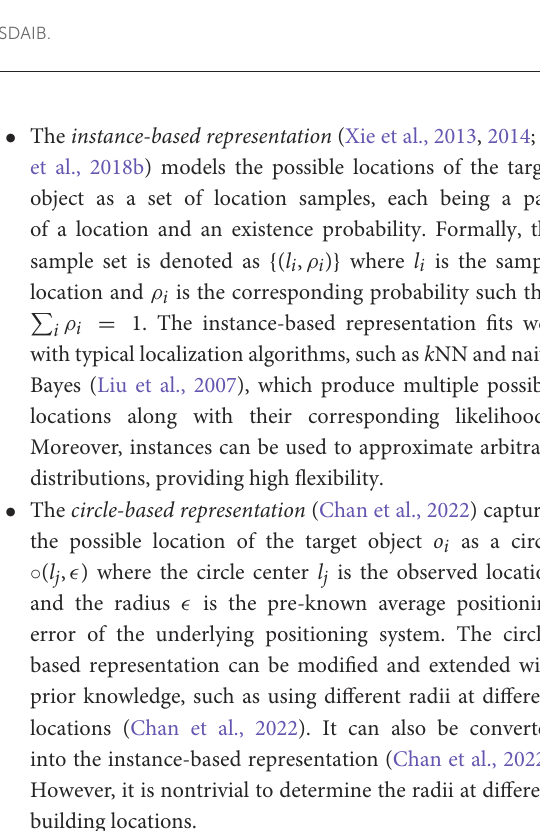
FIGURE5 The classification of the approaches for handling spatial data uncertainties in SDAIB.